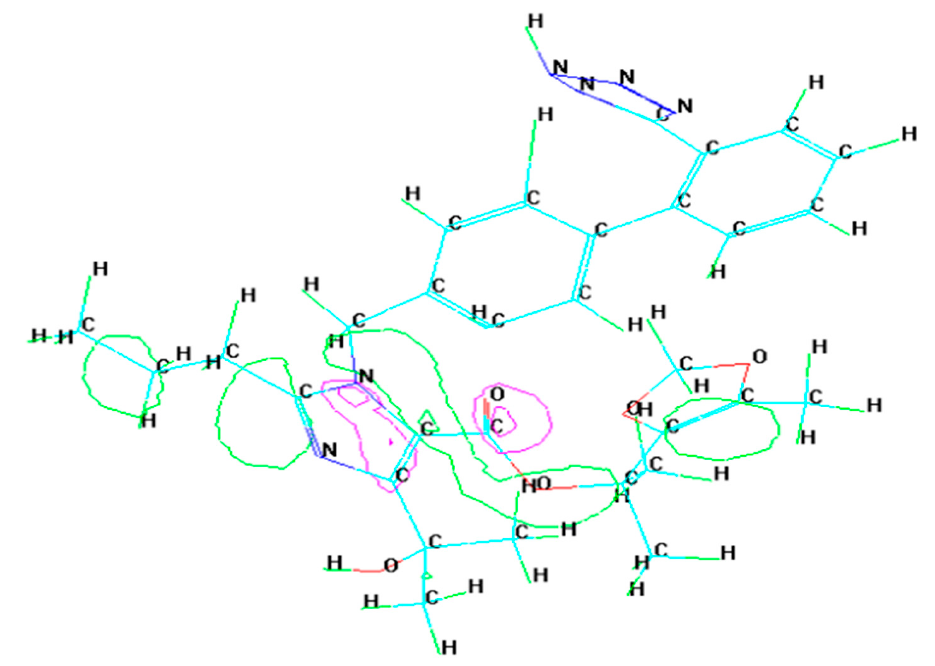
Figure 3. HOMO energy state of olmesartan.